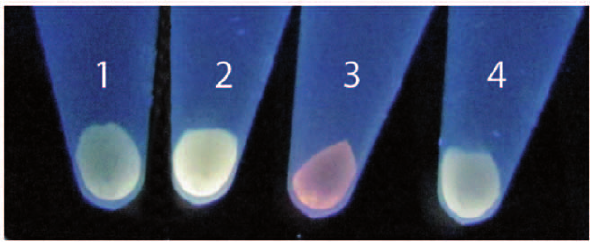
Figure 8. Effect of temperature, microaerophilic conditions and citrate on E.coli fluorescence. UV-exposed E. coli AG1/pCA24N gshA cells previously incubated under NP biosynthesis conditions with some modifications: 1, control (37 u C); 2, increased incubation temperature (42 u C); 3, reducing agent (citrate buffer pH 7.0); 4, microaerophilic conditions.